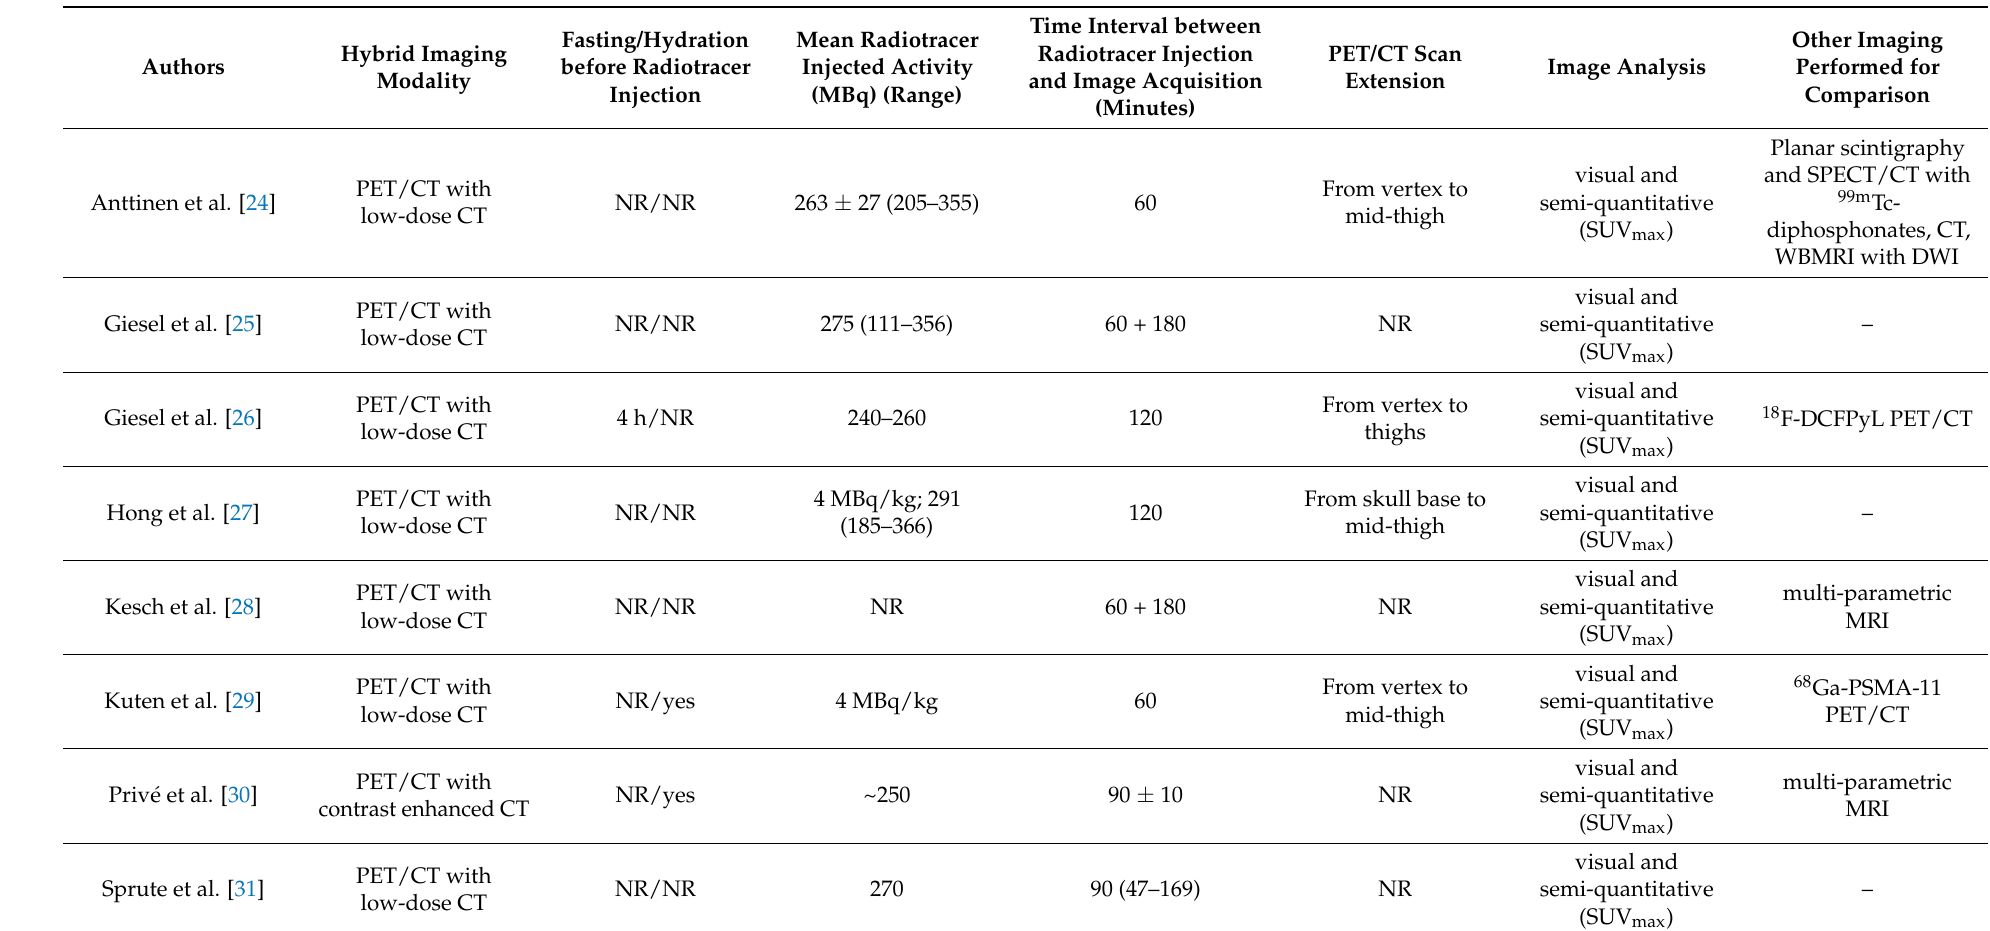
Table 2. Technical aspects of 18 F-PSMA-1007 PET/CT in the included